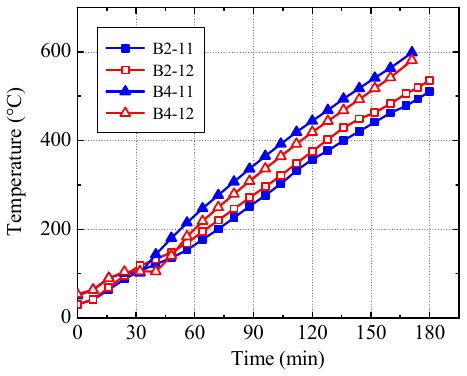
Figure 16. Measured temperature-time curves of Thermocouples 11 and 12.